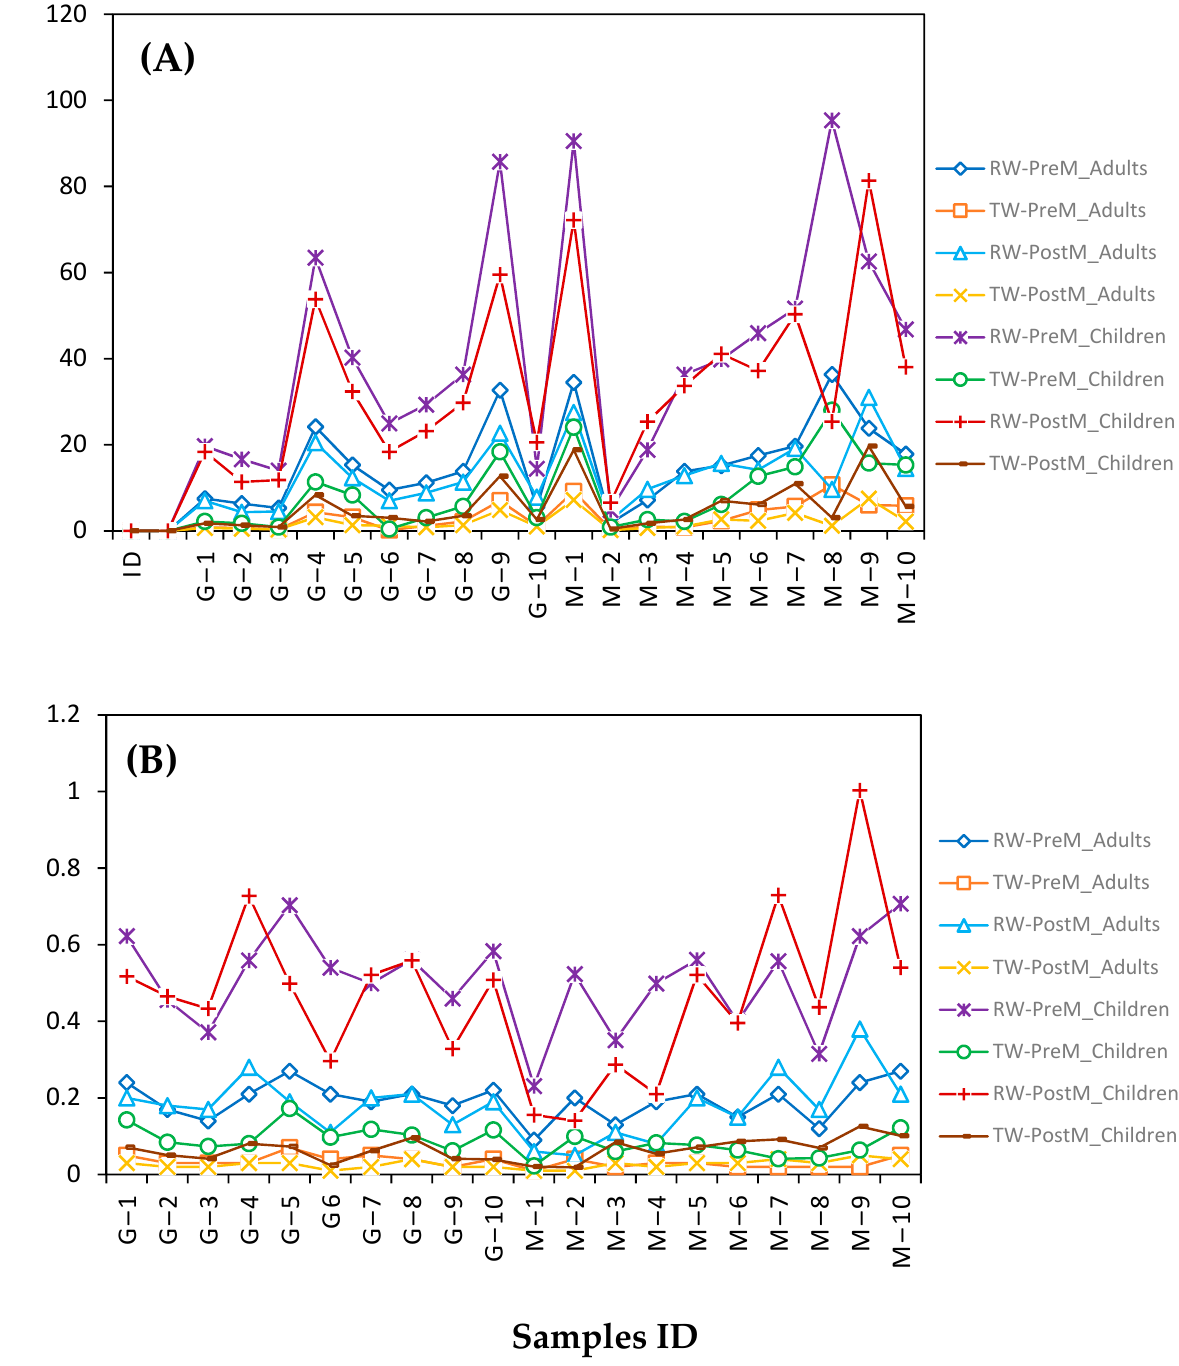
Figure 7. Hazard quotient (HQ) of As ( A ) and Fe ( B ); in raw and treated water by AIRPs for adults and children during- monsoon and post-monsoon in rural areas of Bangladesh (RW-PreM, TW-PreM, RW-PostM, and TW-PostM refer to raw water pre-monsoon, treated water pre-monsoon, raw water post-monsoon, and treated water post-monsoon, respectively). and post-monsoon is presented in Figure 8. The threshold value for CR is 10 − 6 –10 −